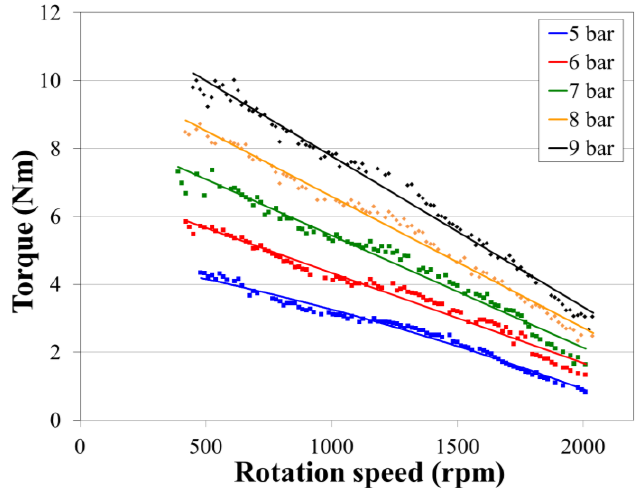
Figure 4. Torque output of the compressed air engine at different rotation speeds and supplied air pressures.